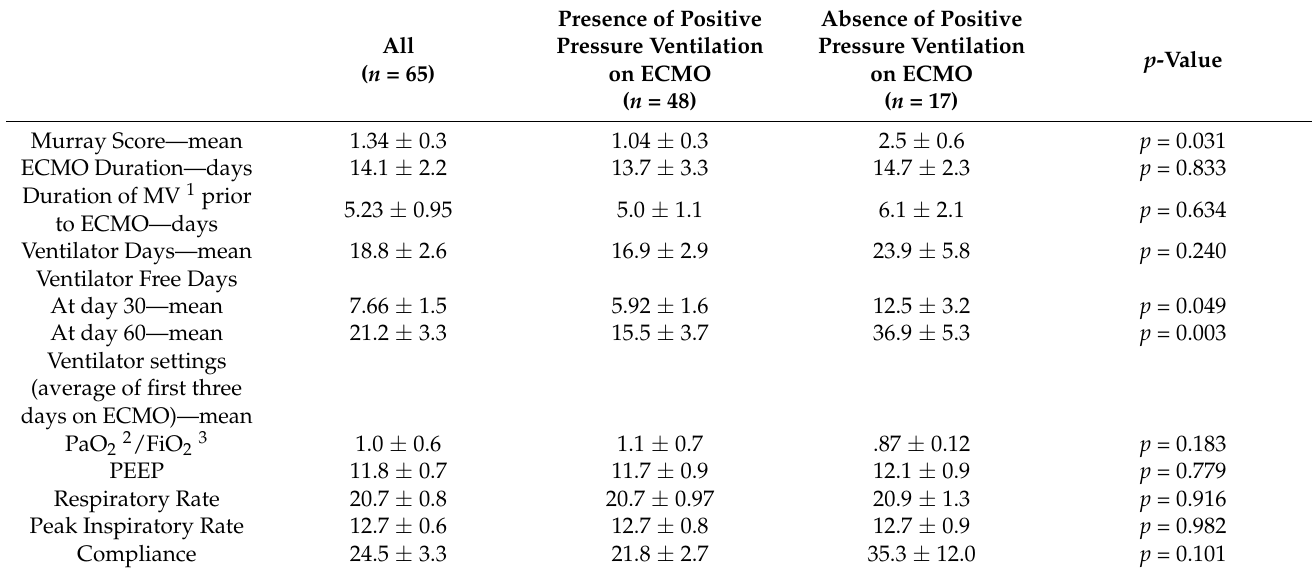
Table 2. Extracorporeal membrane oxygenation (ECMO) and ventilator